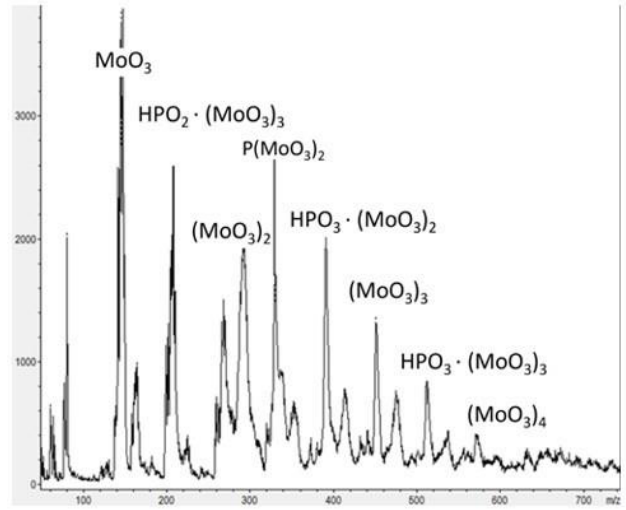
in the negative ion detection protocol.